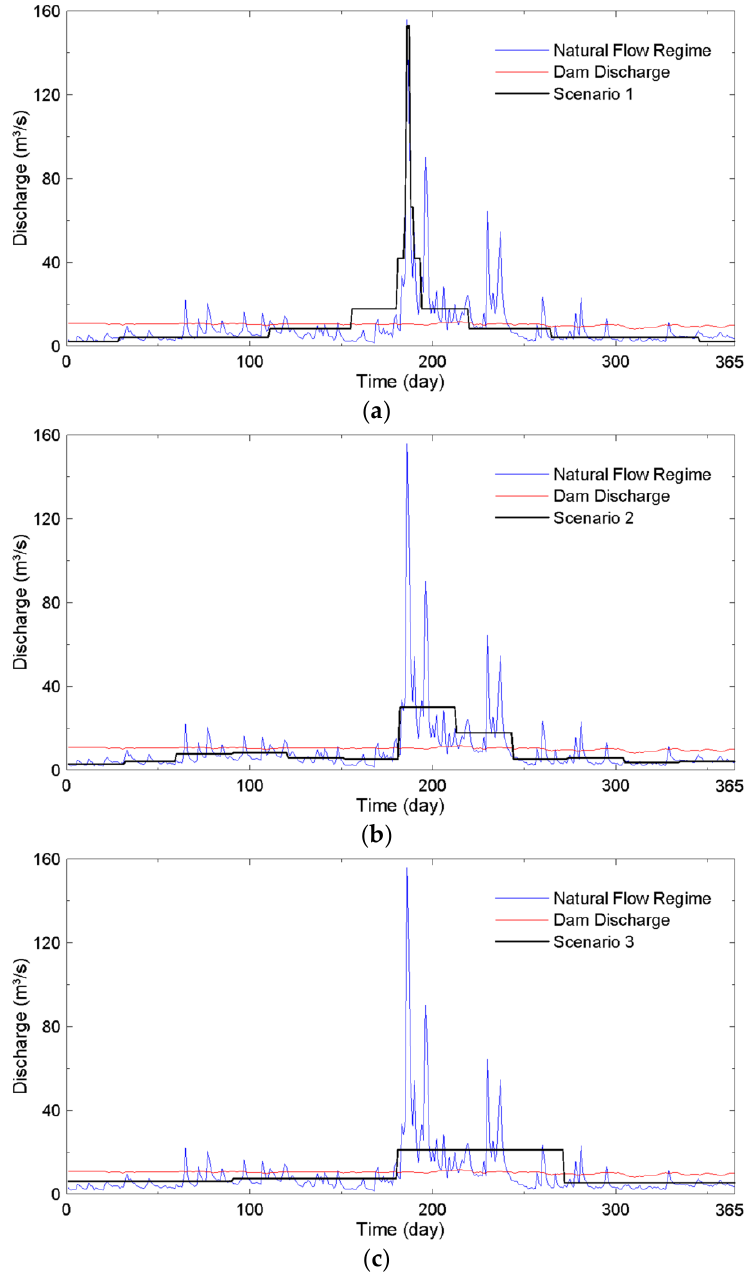
Figure 8. The scenarios using the building block approach (BBA): ( a ) scenario 1, ( b ) scenario 2, and ( c ) scenario 3.